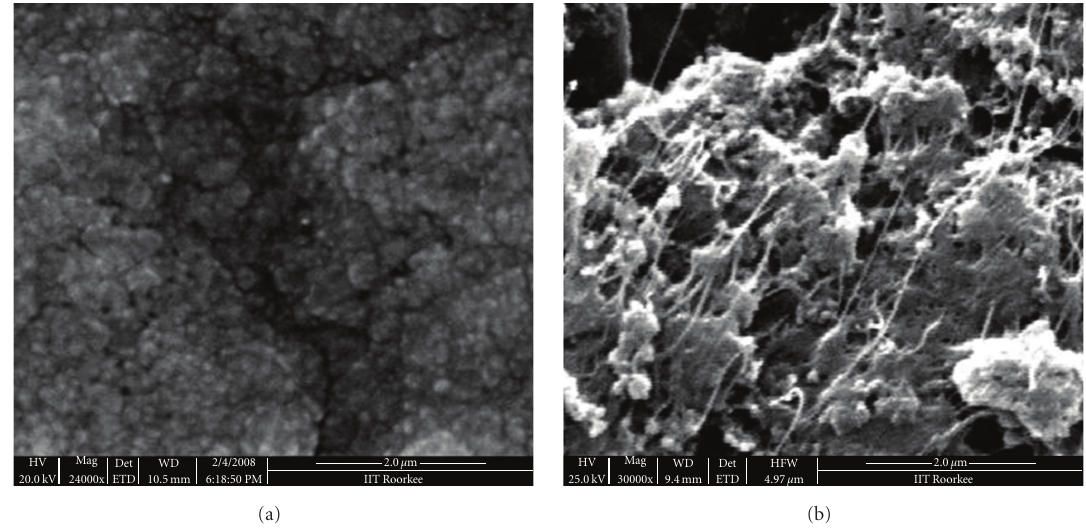
Figure 1: Typical FE-SEM images of (a) bare and (b) SWNT/EPPGE.